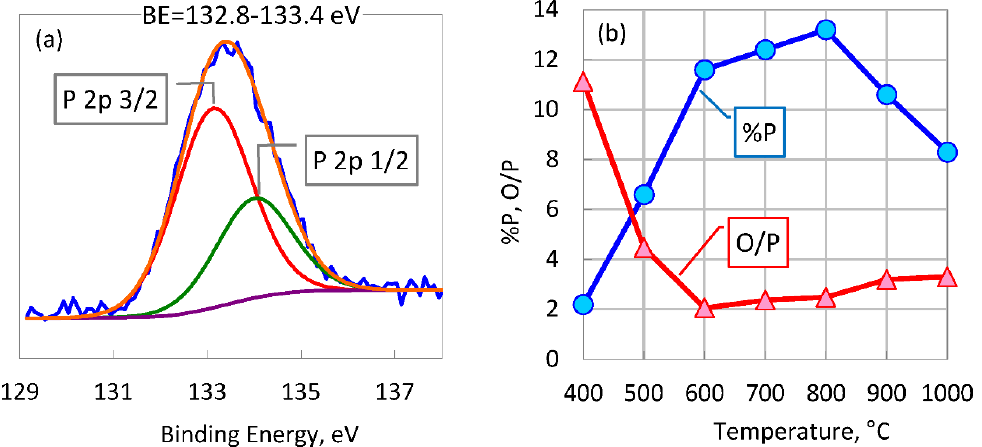
Figure 5. High-resolution X-ray photoelectron spectrum of P 2p peak of polyimide-derived carbon obtained with phosphoric acid at 800 °C ( a ) and temperature evolution of phosphorus content and atomic O/P ratio ( b ).